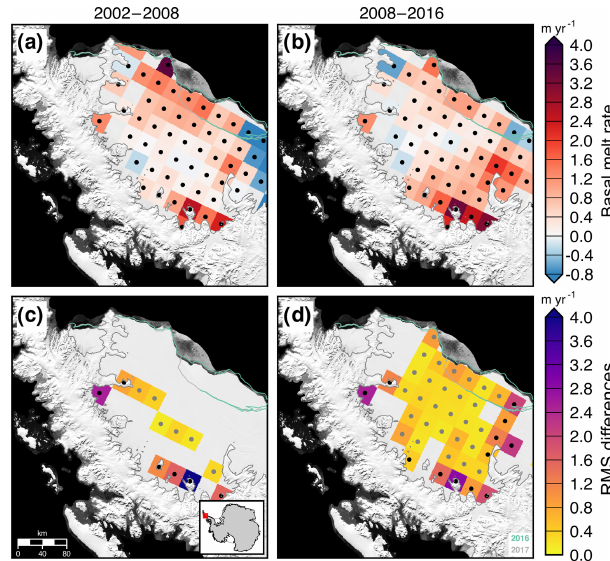
Figure 7. Estimated basal melt rates (a–b) using radar altimetry from Adusumilli et al. (2018) and differences from melt rates de- rived from NASA–CECS Pre-IceBridge and NASA Operation Ice- Bridge (c–d) of the Larsen-C Ice Shelf for two periods, 2002–2008 and 2008–2016. Stipples indicate locations with valid radar altime- try data (a–b) and coincident airborne laser altimetry data (c–d) . MEaSUREs InSAR-derived Antarctic grounded ice boundaries are denoted in gray (Mouginot et al., 2017b). The 2016 and 2017 ice shelf extents delineated from MODIS imagery are denoted in green and light gray, respectively (Scambos et al., 2001). Plots are over- laid on a 2008–2009 MODIS mosaic of Antarctica (Haran et al., 2014). The inset map denotes the location of the